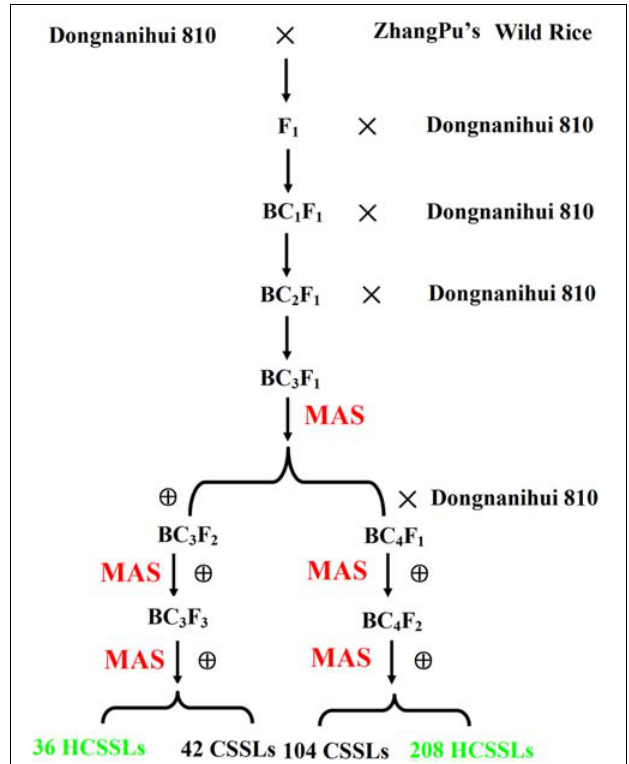
FIGURE 2 | Flowchart of the development of CSSLs and HCSSLs in the present